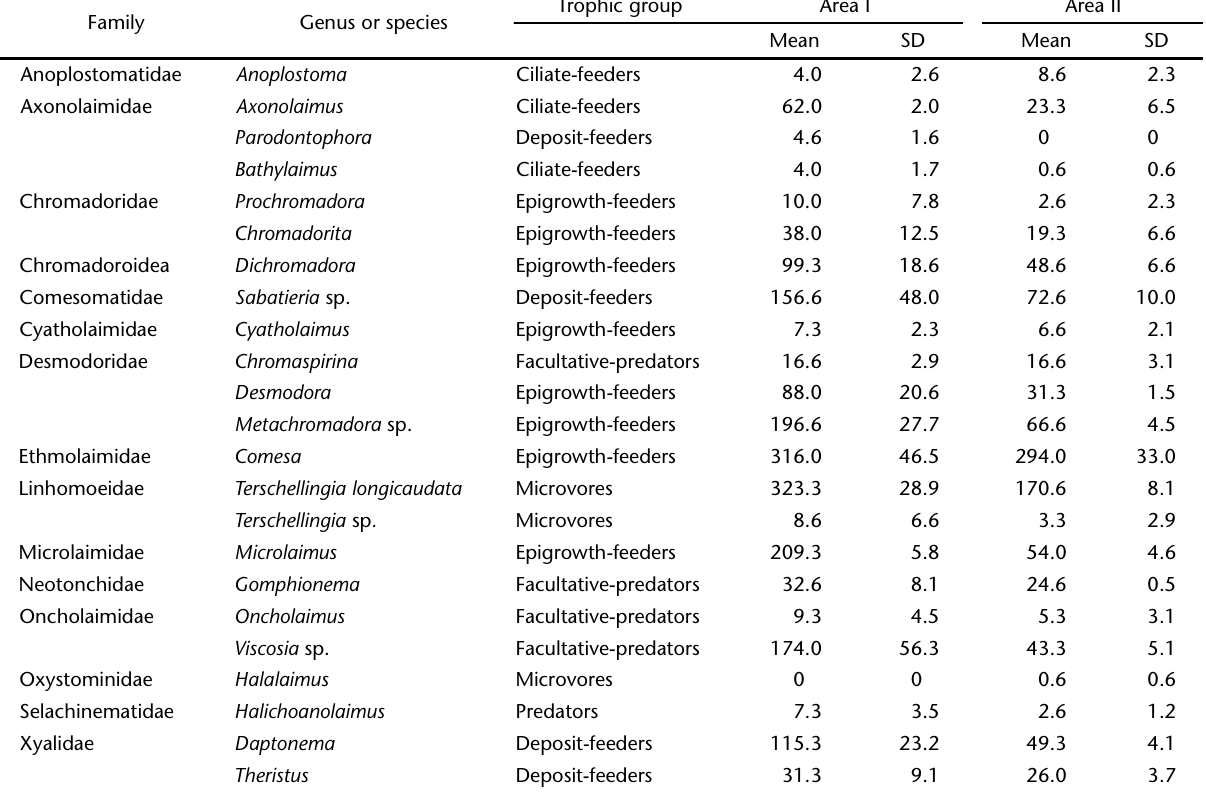
Table I. Families, genera and trophic groups (M OENS & V INCX 1997) of nematodes found in the two experimental areas, expressed as mean densities per 10 cm 2 and standard